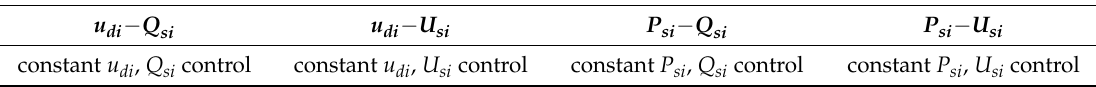
Table 1. Control Modes of